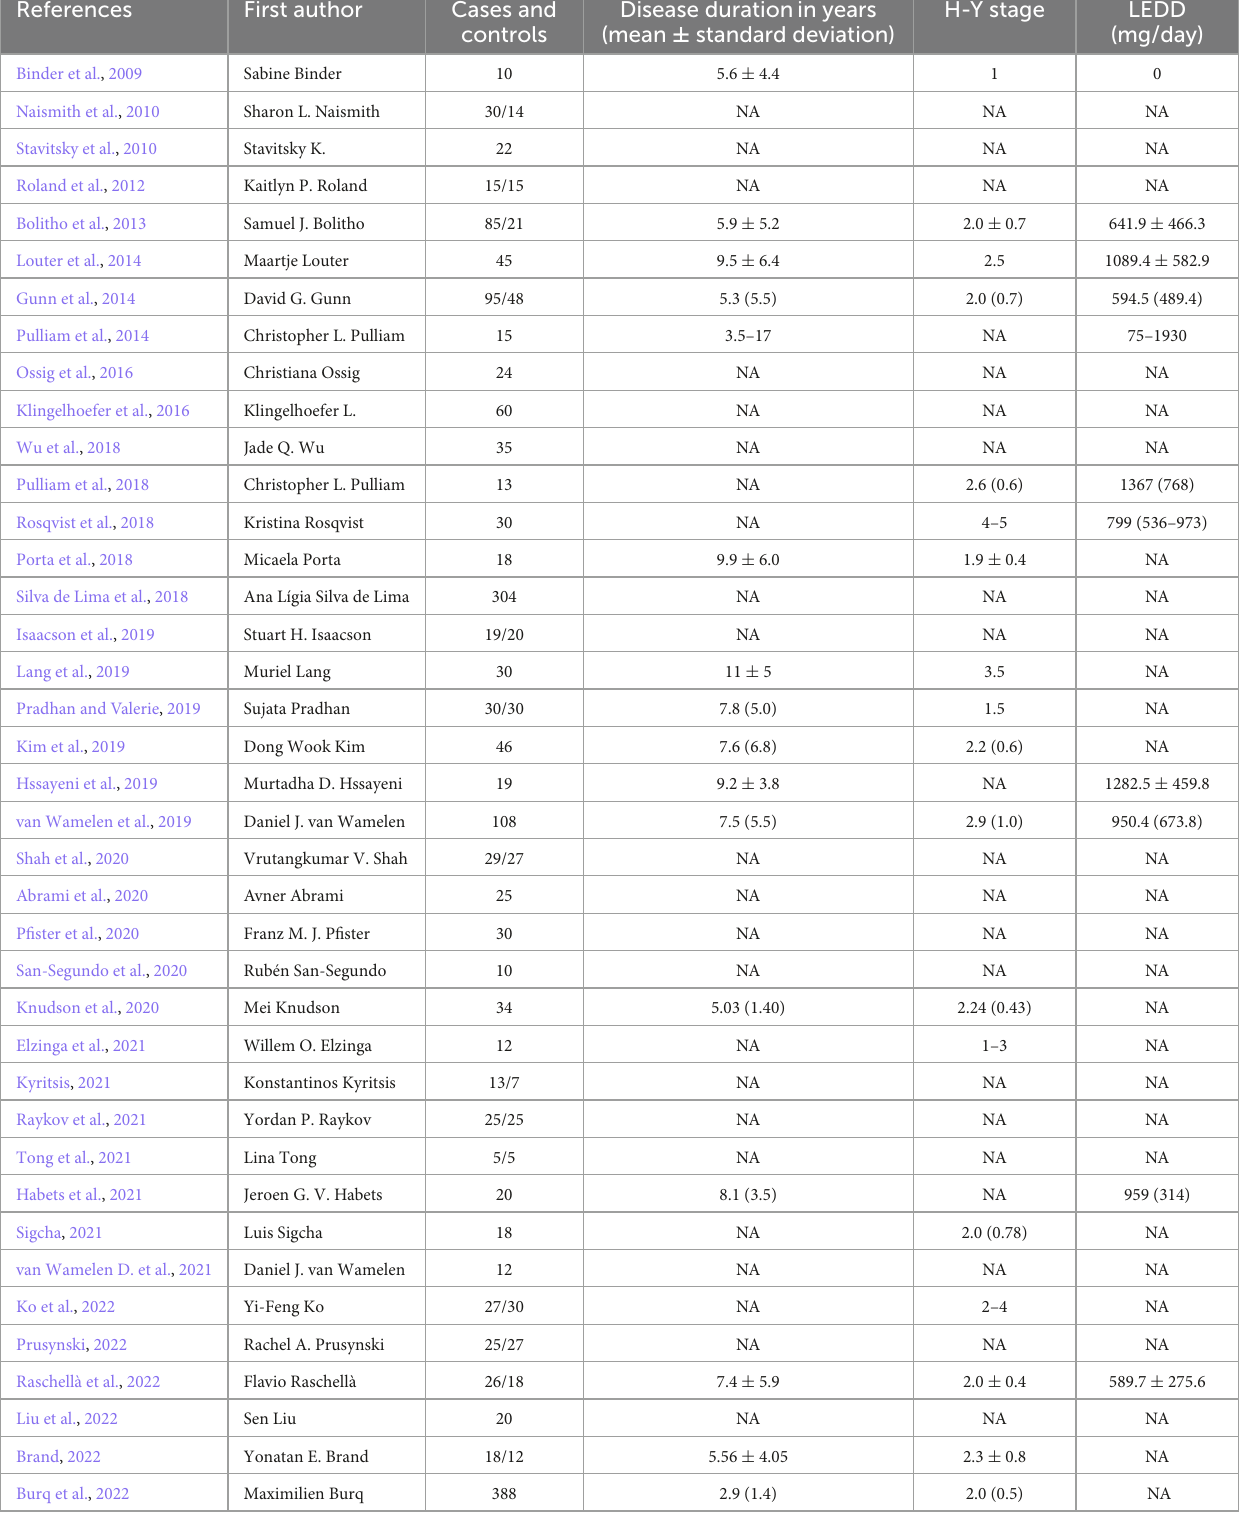
TABLE 1 Included articles and related